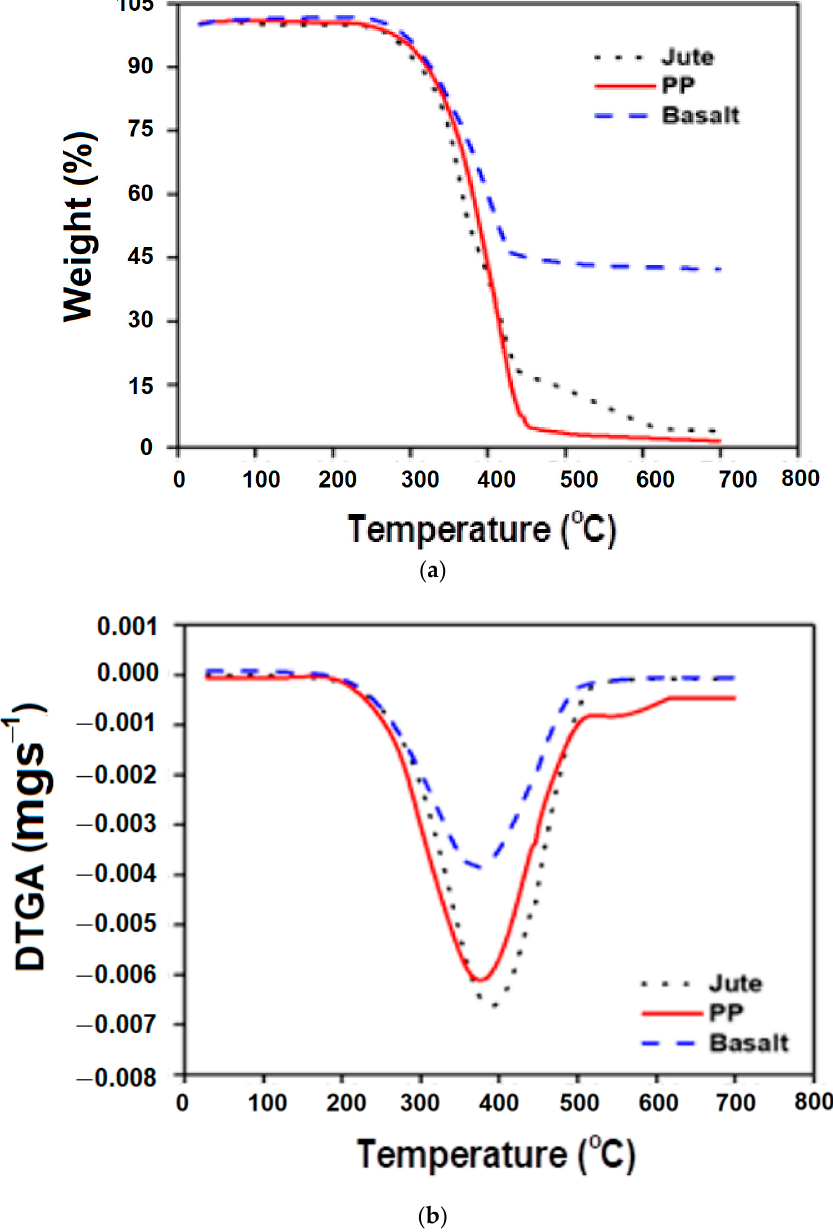
Figure 6. The thermal analysis of the composites: ( a ) TGA, ( b ) DTGA.